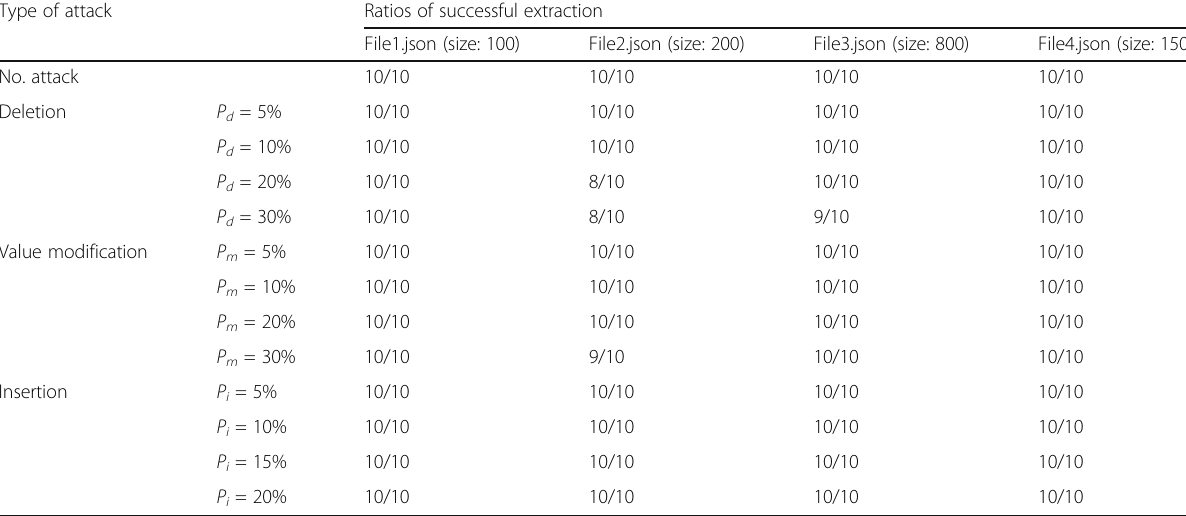
Table 2 Ratios of successful extraction under different attacks for semi-structured data Type of attack Ratios of successful extraction